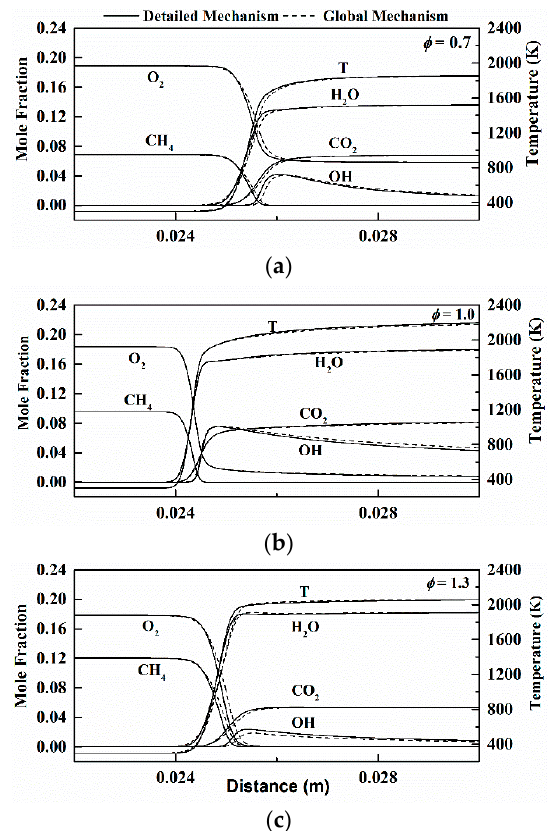
Figure 7. Distribution of major components, critical intermediate components, and temperatures in the case with added ozone concentration of 5000 ppm. For cases, ( a ) ϕ = 0.7; ( b ) ϕ = 1.0; ( c ) ϕ = 1.3.